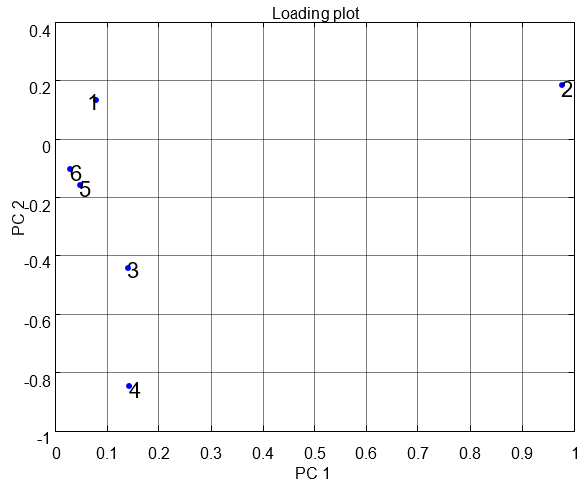
Figure 7. Multivariate technique on organic gases fractional feature loading design.